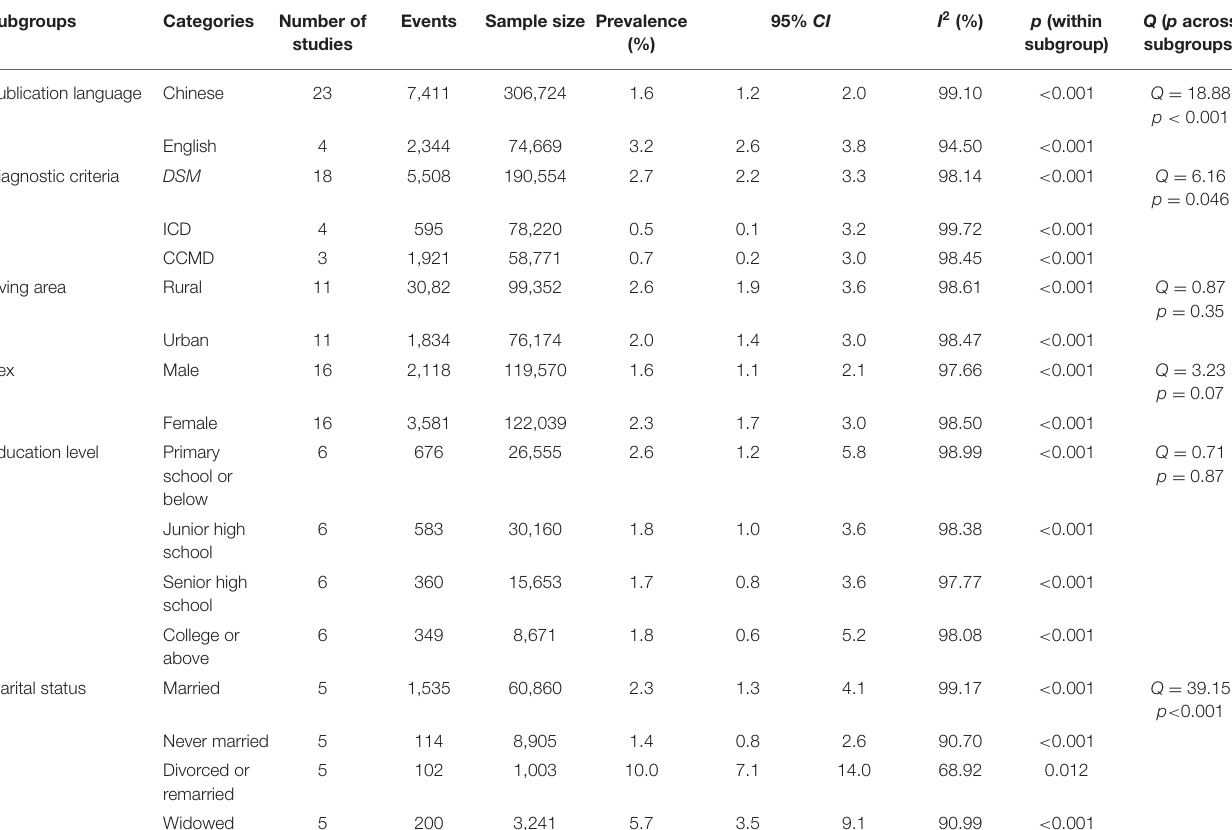
TABLE 2 | Subgroup analyses of lifetime prevalence of MDD in China. Subgroups Categories Number of